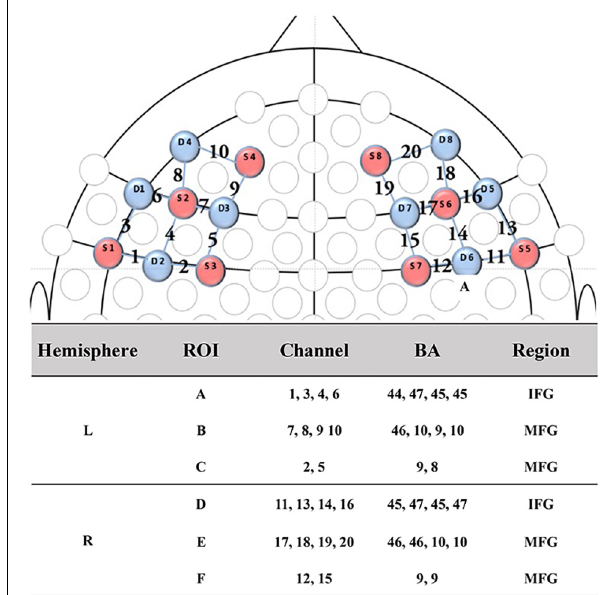
FIGURE 2 | fNIRS channel and probe configuration. The 2D map illustrated the distribution of probes (red and blue representing the source and detector probe, respectively) and 20 channels. While, the table showed the ROIs, details of channels, brain regions and correspondent Brodmann area. ROI, regions of interest; IFG, inferior frontal gyrus; MFG, middle frontal gyrus; BA, Brodmann